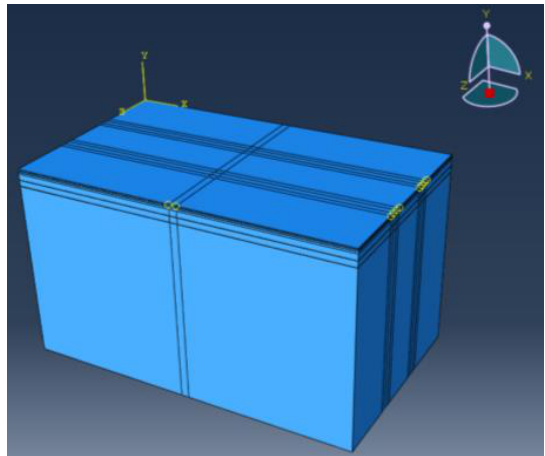
Figure 5. Finite element for the pavement structure.